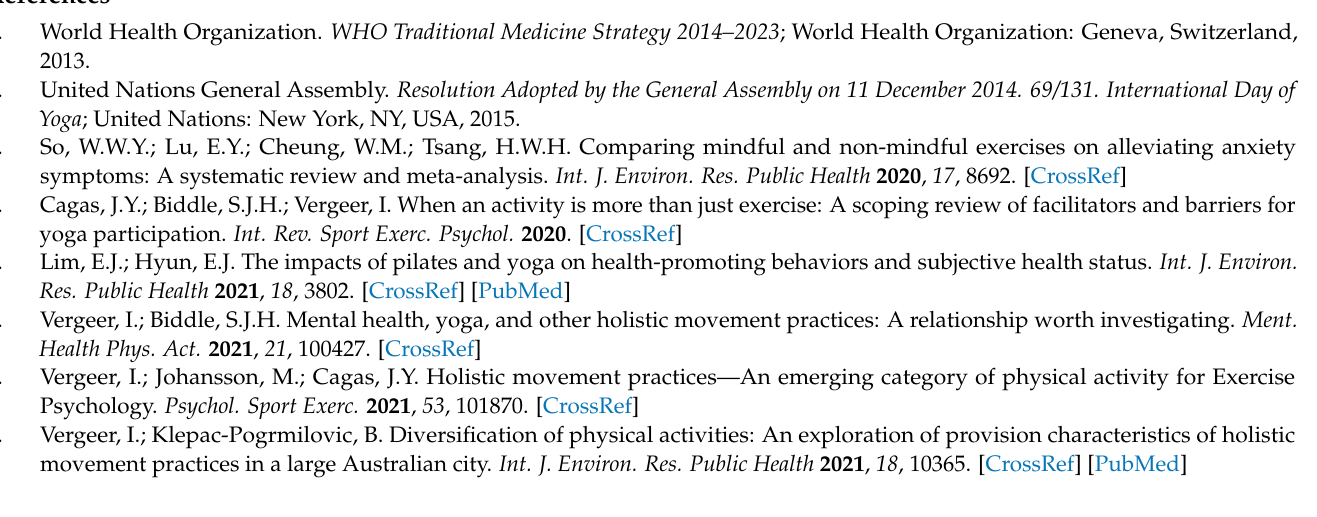
(Females), Table S5: Correlations between years of practice and participation motives (Overall), Table S6: Correlations between years of practice and participation motives (Males), Table S7: Correlations between years of practice and participation motives (Females), Table S8: Descriptive statistics of Conformity to Masculine Norms subscales by gender and participant subgroups, Table S9: Differences in participation motives across participant subgroups (Overall), Table S10: Differences in participation motives across participant subgroups (Males), and Table S11: Differences in participation motives across participant subgroups